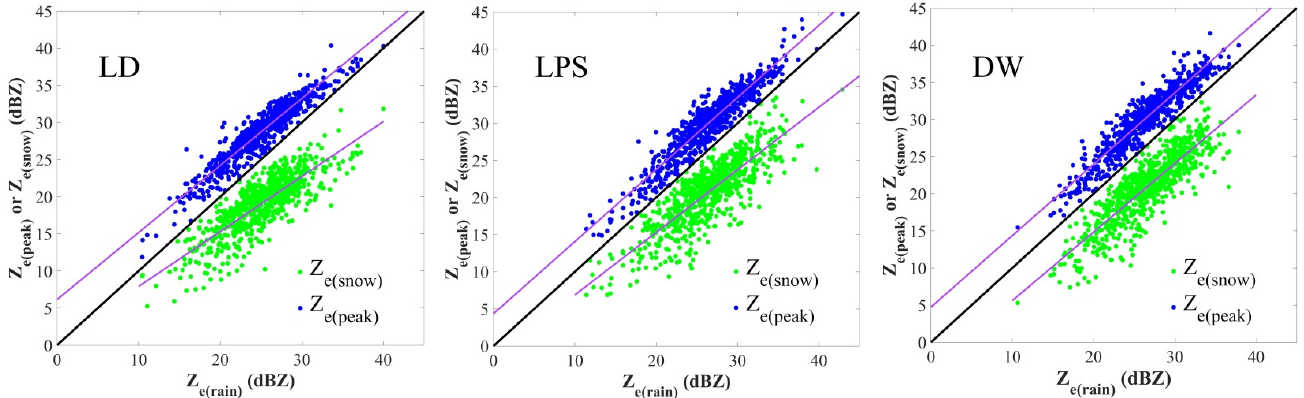
Figure 7. Scatterplots of the rain reflectivity [ Z e (rain) ] versus the snow reflectivity [ Z e (snow) ] or peak reflectivity [ Z e (peak) ] at LD, LPS, and DW. The measurement period is from May to September 2021. The 1:1 line is also shown.